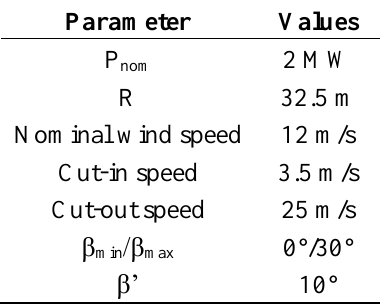
Table 2. Wind turbine parameter